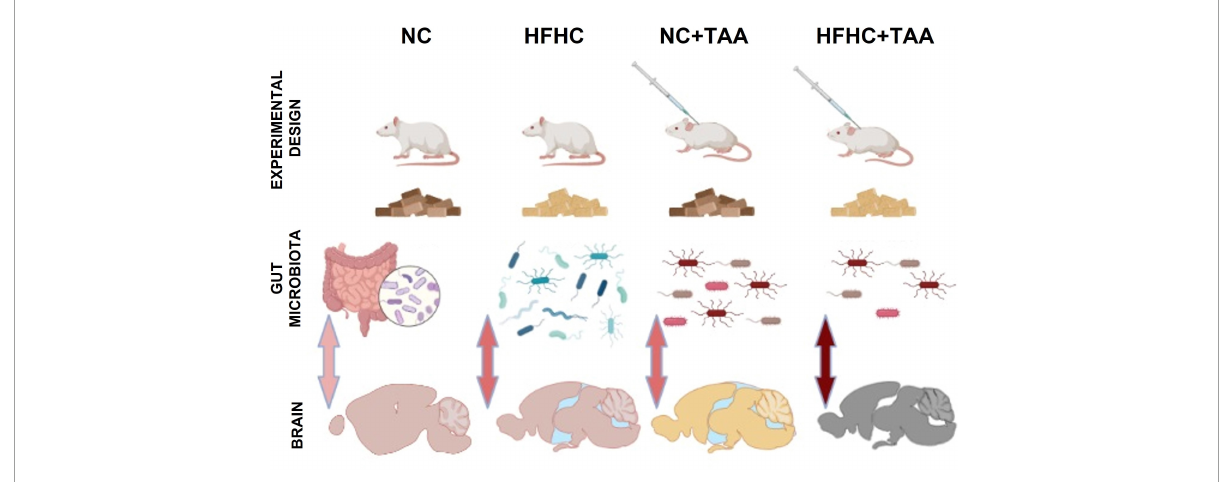
FIGURE15 Graphic model of the study. The liver disease spectrum was studied in a rat model by using a high-fat, high-cholesterol diet (HFHC), control diet + thioacetamide (NC + TAA), and high-cholesterol diet + thioacetamide (HFHC + TAA). The experimental groups displayed changes in the gut microbiota at a compositional level, diversity, and bacterial community structure. Liver disease and gut dysbiosis also affected oxidative metabolism of several brain regions, which was associated with worsened object recognition and working